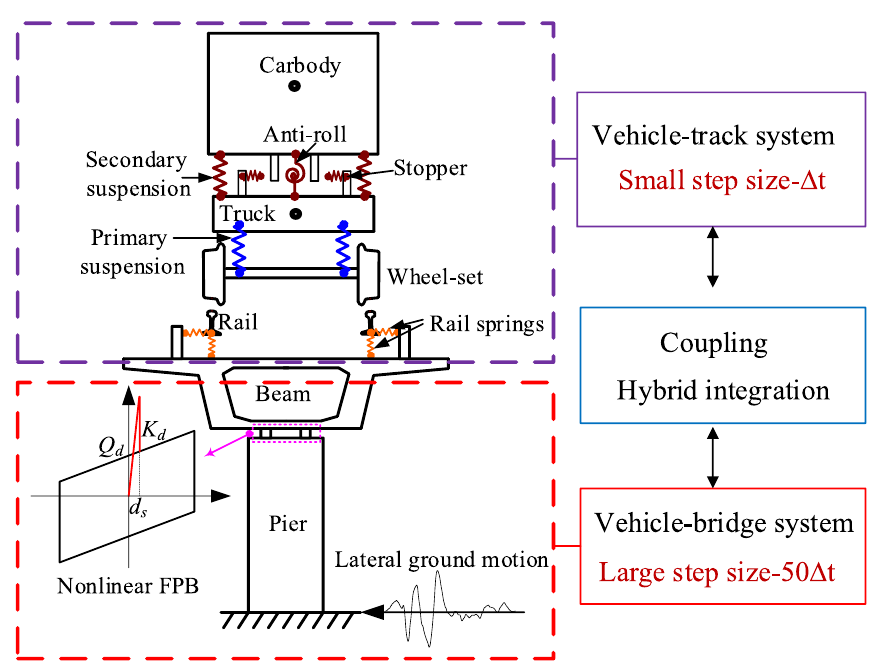
Fig. 16 vehicle-track-bridge dynamic interaction